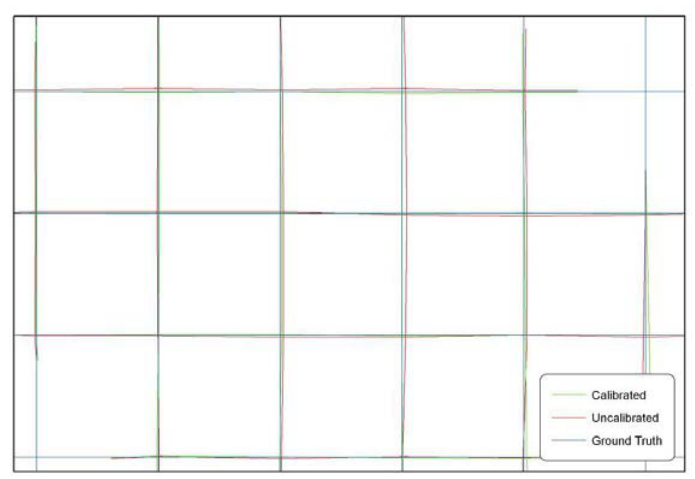
Figure 4. Comparison of rectified images obtained modeling or not modeling the lens radial